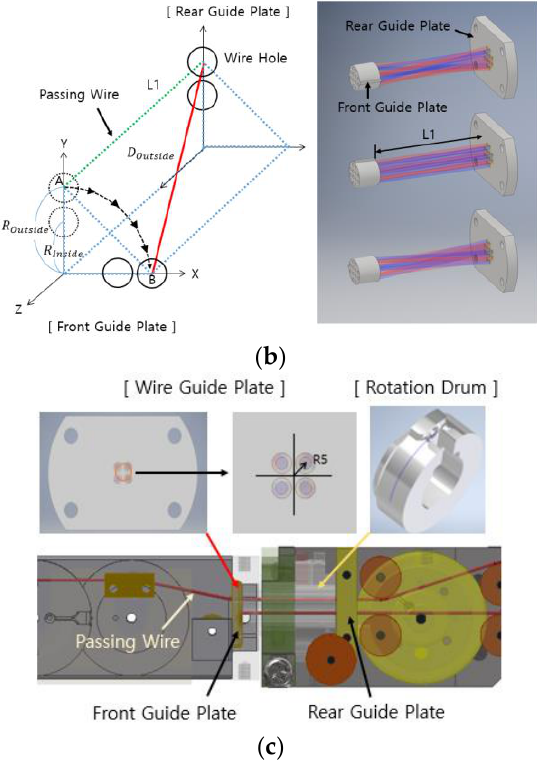
Figure 6. Structure of the 1st DOF: ( a ) layout; ( b ) example of turning 90° (left); ( c ) 5th DOF.